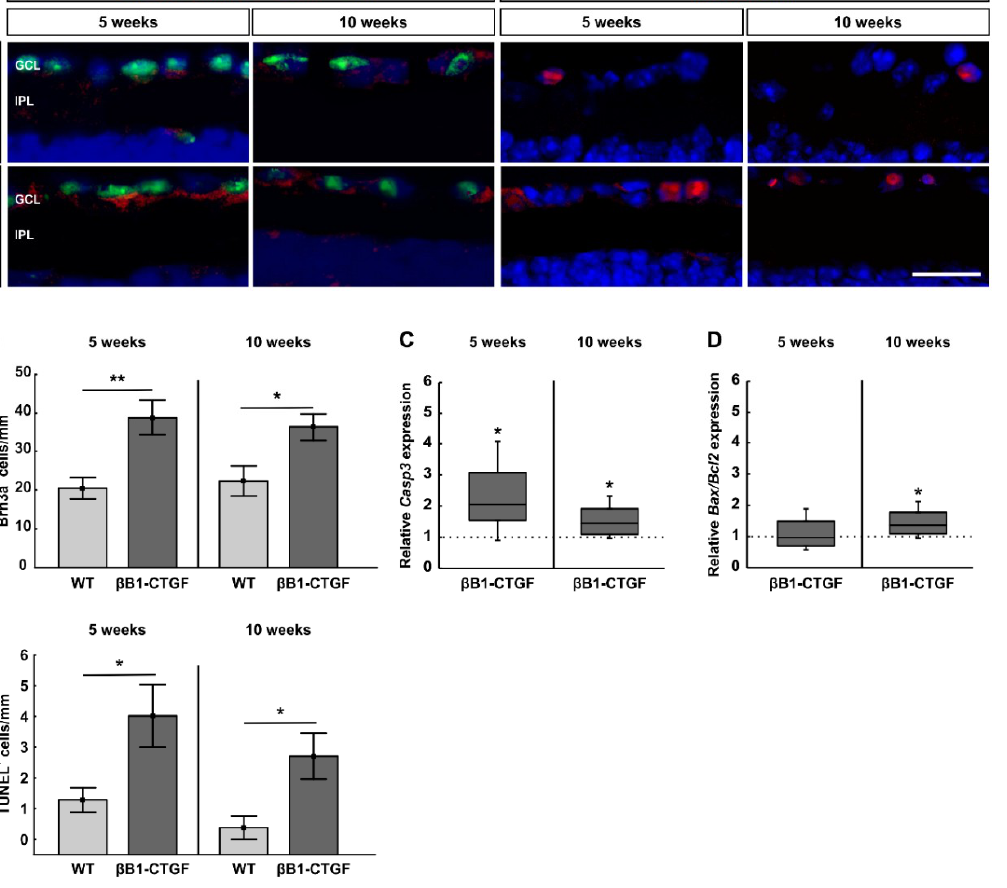
Figure 2. Increased apoptosis rate in retinal ganglion cells. ( A ) Retinae were stained with the apoptosis marker cleaved caspase 3 (red) in combination with Brn3a (green) at 5 and 10 weeks (n = 7–8/group). Furthermore, apoptotic cells were visualized using terminal deoxynucleotidyl transferase-mediated dUTP nick end labeling (TUNEL) staining (n = 5/group). Cell nuclei were visualized with DAPI (blue). ( B ) Significantly more cleaved caspase 3 + RGCs were revealed in β B1-CTGF mice compared to in WT animals at 5 ( p = 0.005) and 10 weeks ( p = 0.02). ( C ) The mRNA expression levels of Casp3 were upregulated at 5 ( p = 0.02) and 10 weeks ( p = 0.03). ( D ) At 5 weeks, the mRNA expression levels of Bax/Bcl2 were not altered in β B1-CTGF mice. In contrast, a significant upregulation of Bax/Bcl2 levels was noted in 10-week-old transgenic animals ( p = 0.04). ( E ) A higher number of TUNEL + apoptotic cells in the ganglion cell layer was reveled in 5- ( p = 0.03) and 10-week-old β B1-CTGF mice compared to in WT ( p = 0.02). Abbreviations: GCL = ganglion cell layer, IPL = inner plexiform layer. Values are mean ± SEM for immunohistology and median ± quartile + maximum/minimum for RT-qPCR. The dotted lines in C and D represent the relative expression levels of the WT group. Scale bar: 20 µ m. * p < 0.05, ** p <